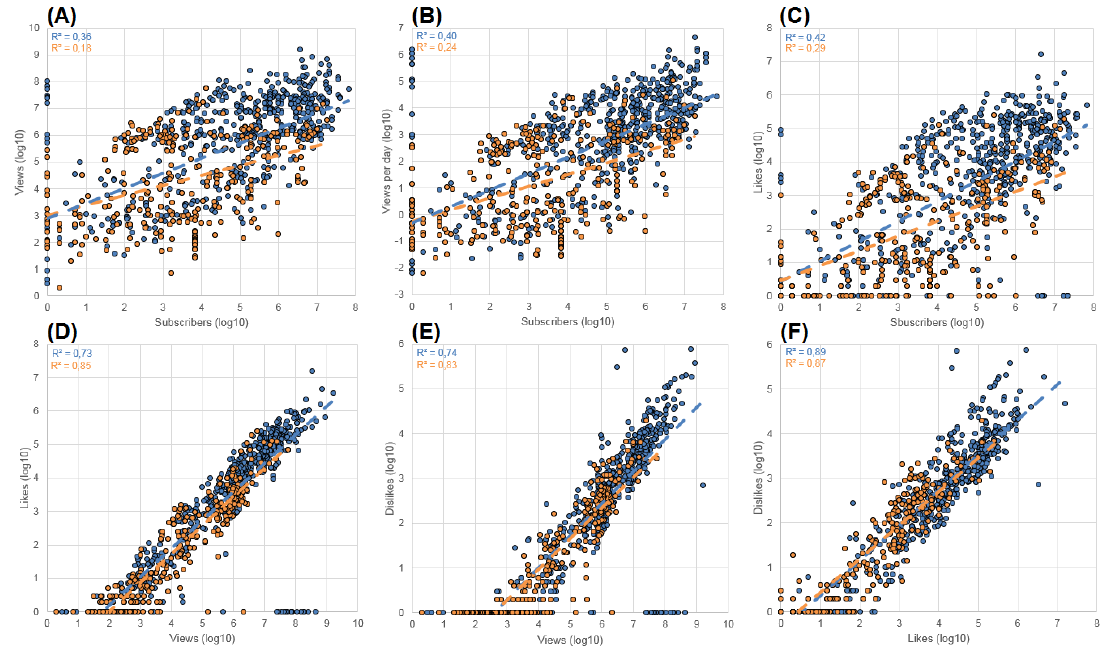
Figure 5. The relationship between the total number of subscribers, views, views per day, likes and dislikes. Data for the whole dataset are colored in blue while data for the subset of videos with factual cryospheric content are colored in orange.